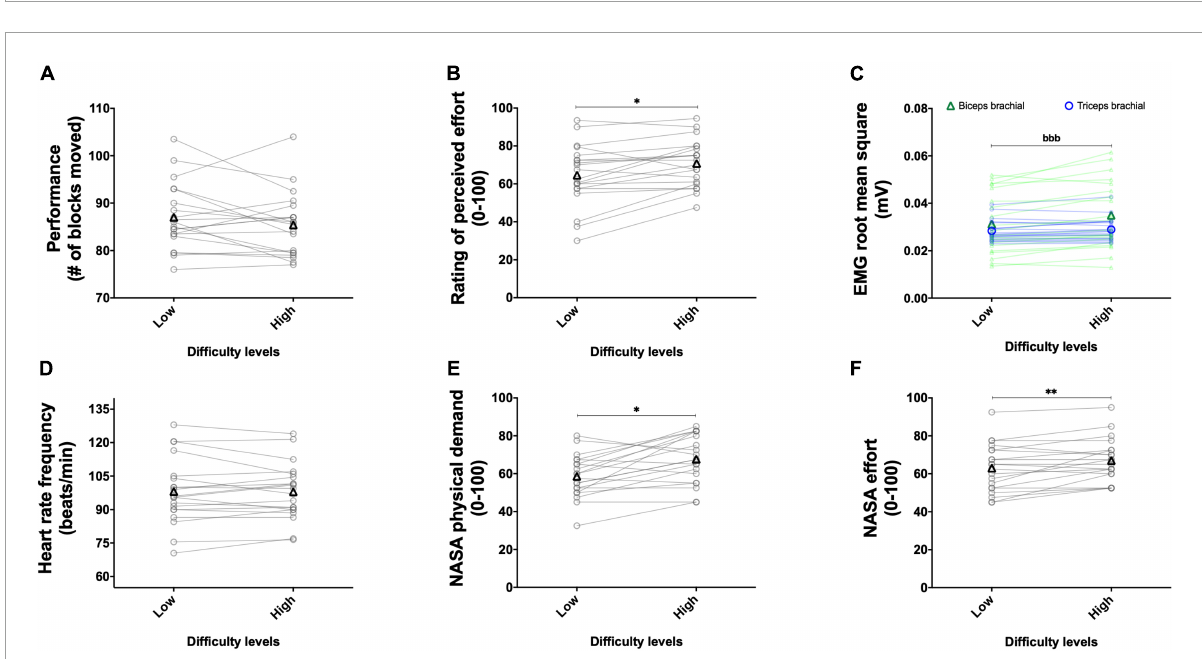
FIGURE10 Experiment 2B: Adding weight on the forearm to alter task difficulty during the box and block test with its validated instructions. Effect of weight manipulation on performance ( A , n = 20), rating of perceived effort ( B , n = 20), EMG root mean square of the biceps (green line) and triceps (blue line), brachial muscles ( C , n = 20), heart rate frequency ( D , n = 20), and NASA TLX scores for physical demand ( E , n = 20) and effort ( F , n = 20) during the box and block test with its official instructions. Data are presented as the main effect of difficulty, except for panel (C) presenting the effort difficulty × muscle interaction. Individual data are presented in light markers and means in dark markers. *Main effect of difficulty, the difference between two difficulty levels. b is the difference between two difficulty levels for the biceps and triceps brachial muscles, respectively. One symbol: p < 0.05 and two symbols: p < 0.01.